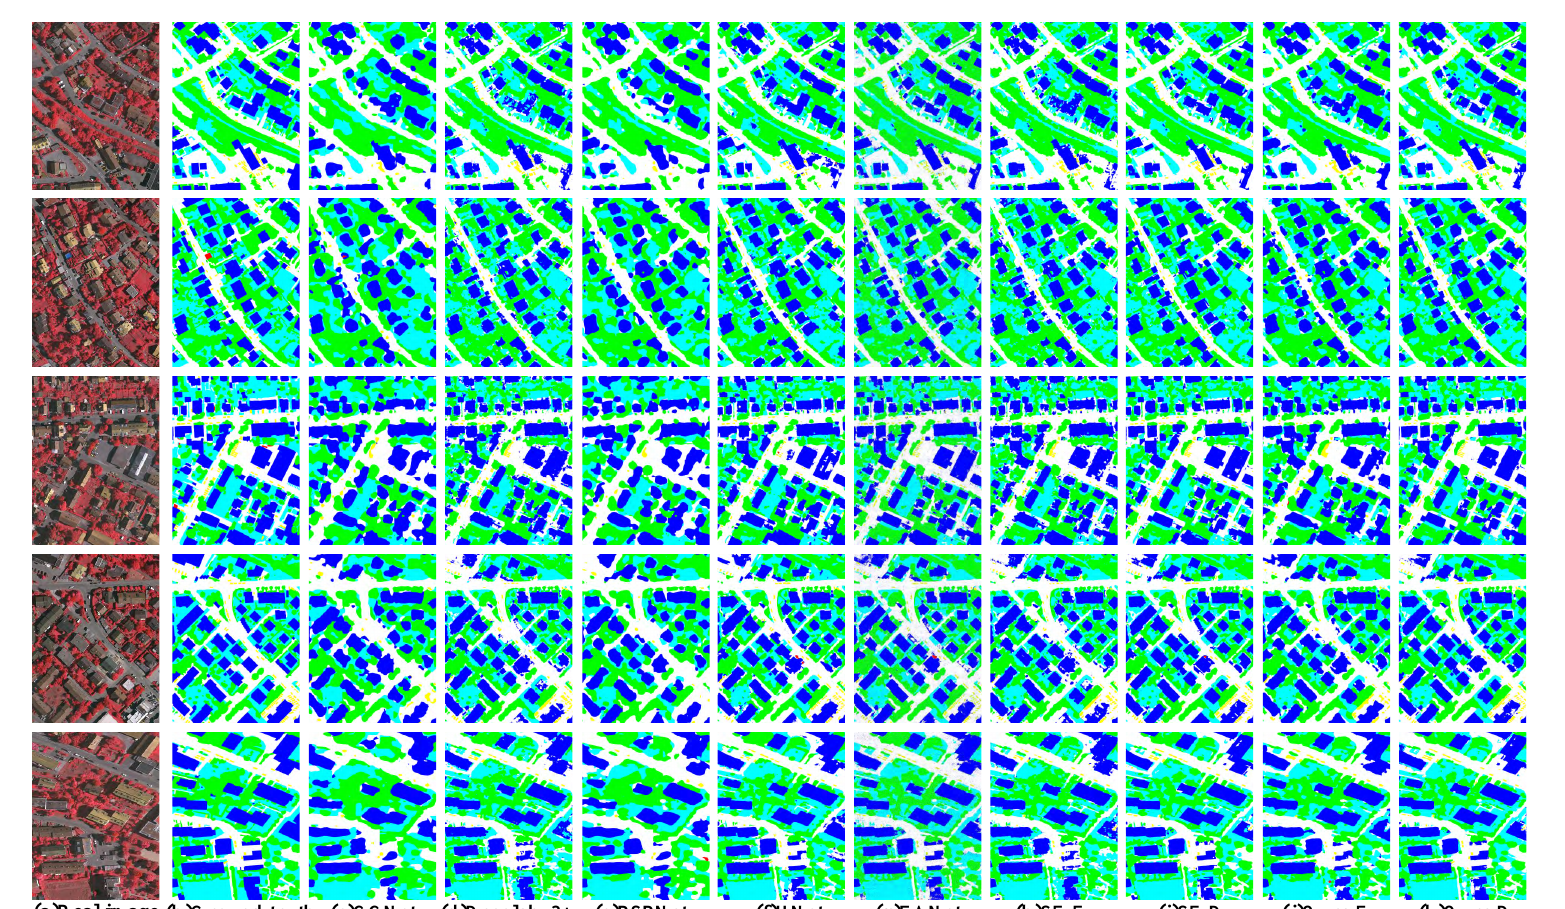
Figure 12. Visualization of all models on Vaihingen dataset. ( a ) Ground truth. ( b ) Results of CCNet. ( c ) Results of Deeplabv3+. ( d ) Results of PSPNet. ( e ) Results of UNet. ( f ) Results of EANet. ( g ) Results of SFNet with FCN. ( h ) Results of SFNet with Deeplab. ( i ) Results of our method with FCN. ( j ) Results of our method with